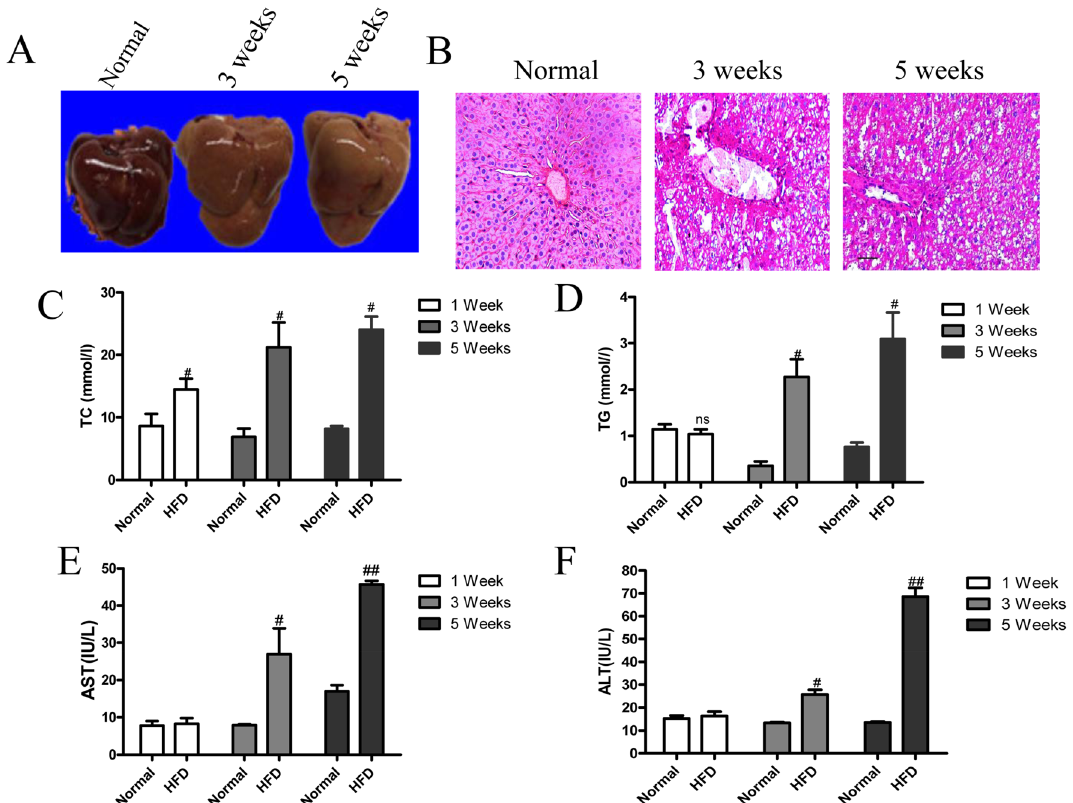
Figure 1. Progression of NAFLD is induced by HFD. ( A ) The characterization of liver morphology. ( B ) H&E staining revealed the development of NAFLD induced by HFD. Scale bar in A = 50 µm. ( C – F ) The levels of TC, TG, ALT and AST of HFD-fed rats at weeks 1, 3 and 5. Mean ± SEM. # P < 0.05, ## P < 0.01 vs. ND-fed